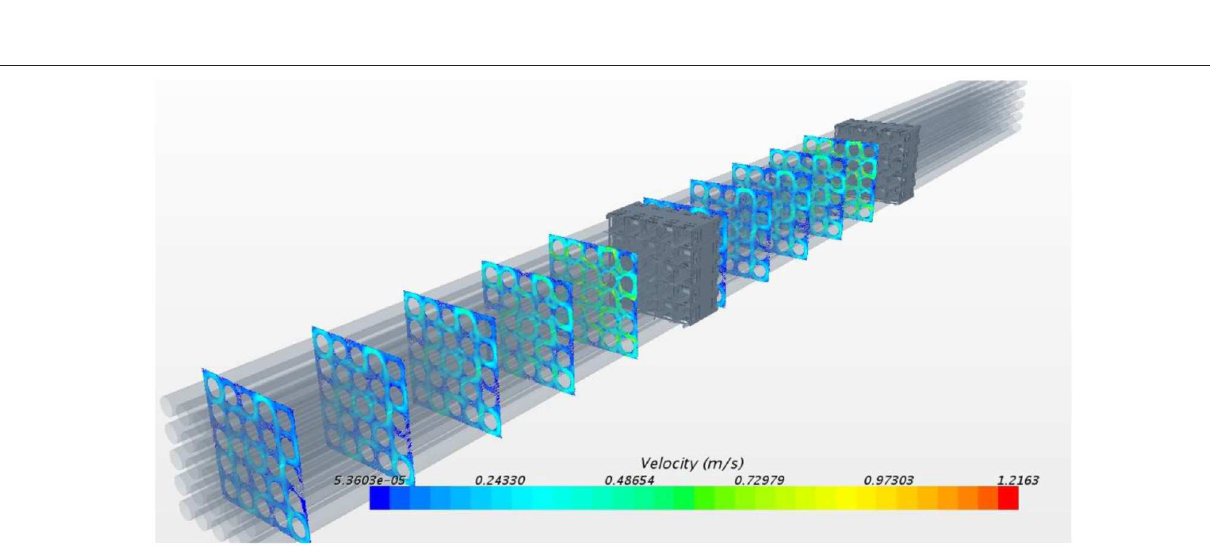
FIGURE 10 | Validation of the computed axial velocity. (A) X 38.8mm, Z